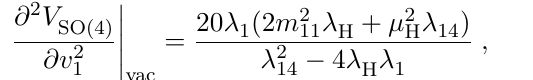
Figure 2 . A benchmark example for the evolution of V = v ), where the coupling coefficients are taken to be µ 2 v 1 2 10 4 GeV 2 , λ = 3 . 006 , λ = 0 . 402 and λ 1 H vev v = 245 . 6 GeV in the above parameter H